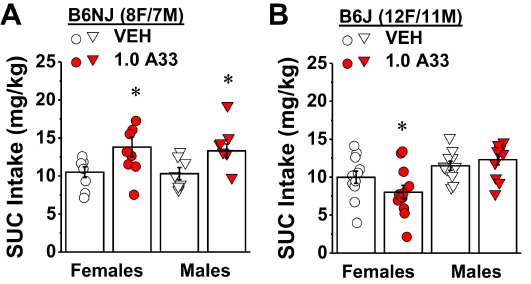
Figure 5. Strain by sex interaction in the effect of A33 on sucrose intake. Summary of the effect of pretreatment with either vehicle (VEH) or 1.0 mg/kg A33 (1.0 A33) on the intake of a 20% sucrose (SUC) solution under a 2 h DID procedure in ( A ) female and male B6NJ mice (8 females/7 males) and ( B ) female and male B6J mice (12 female/11 male). The data represent the mean ± SEM of the number of mice indicated, in addition to the individual data points for each experimental group. * p < 0.05 vs. 0 mg/kg of A33 (main